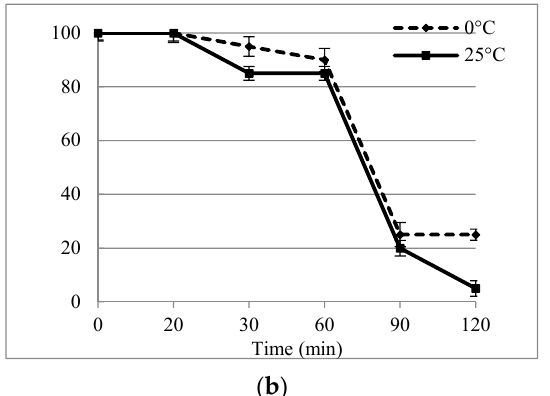
Figure 1. Effect of PVS2 treatment times on regrowth percentage (± SD) of S. rebaudiana apical shoot tips ( a ) and axillary shoot tips ( b ) at 0 ◦ C and 25 ◦ C, after 28 days of culture.